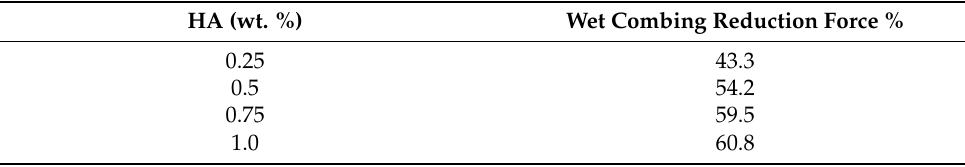
Table 2. Effect of HA Concentration on Wet Combing Reduction